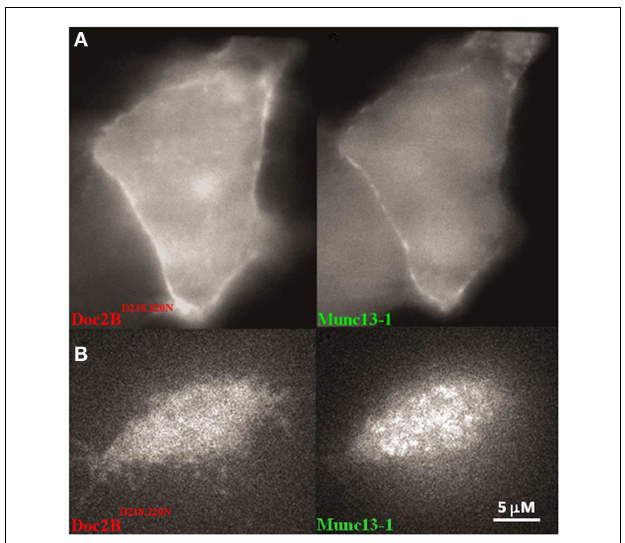
FIGURE 4 |A PC12 cell co-expressing Doc2B D218,220N –mRFP and Munc13-1 wt . (A) Epi-fluorescence images of a PC12 cell co-expressing Doc2B D218,220N –mRFP (left) and Munc13-1 wt –EGFP (right). (B) TIRF images of a PC12 cell co-expressing Doc2B D218,220N –mRFP (left) and Munc13-1 wt –EGFP (right).